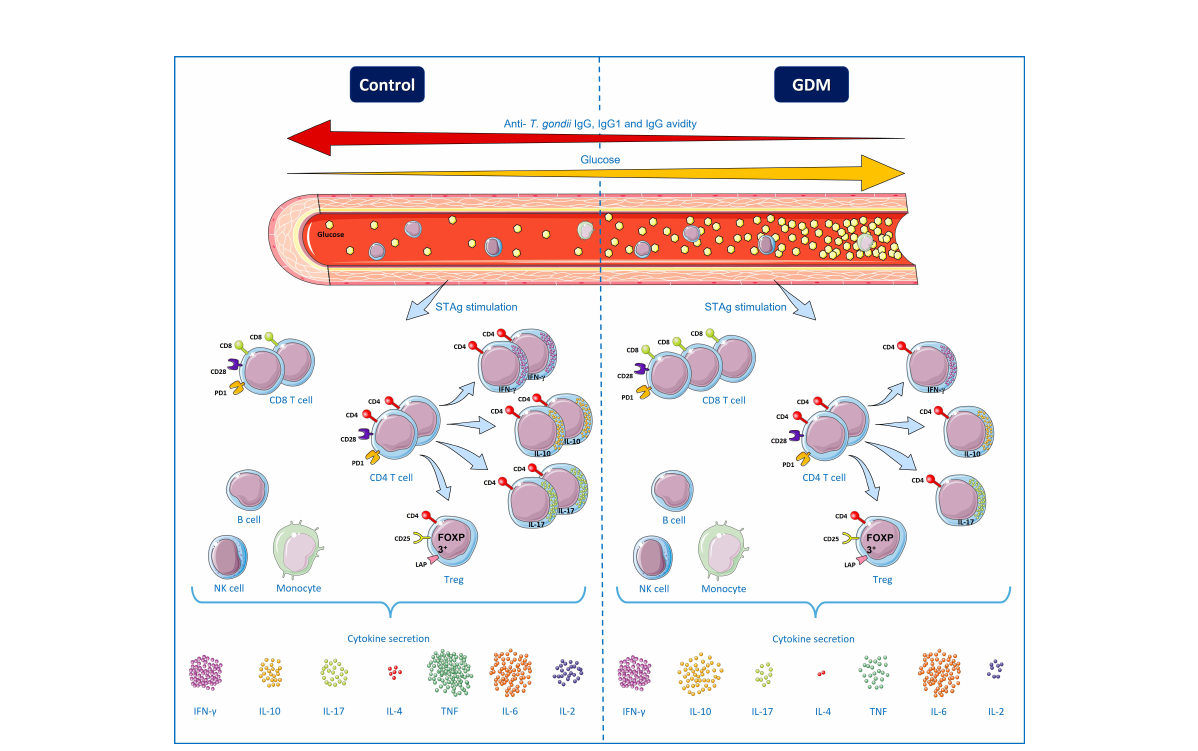
FIGURE 8 Speci fi c T. gondii immune responses from pregnant women chronically infected by the parasite, with and without gestational diabetes mellitus (GDM). High blood glucose levels characterize patients with GDM, while normoglycemic patients were identi fi ed as patients in the control group. There was a negative correlation between the blood glucose of PW and the levels of total IgG, IgG1 and IgG avidity, therefore, the higher the patient ’ s glycemia, the lower the level of anti- T. gondii antibodies. Under polyclonal stimuli (anti-CD3/anti-CD28), the GDM group patients had a higher number of T lymphocytes expressing the markers of cell activation and exhaustion (CD28 and PD-1), but in the presence of STAg, there was no difference. Under STAg stimuli, the number of CD8 + T cells was higher in the GDM group, while the number of CD4 + T cells was similar between the groups. However, the amount of CD4 + T lymphocytes producing IFN- g , IL-10 and IL-17 was signi fi cantly lower in the GDM group, while there was no difference between the groups in the amount of functional CD4 + CD25 High FOXP3 + LAP + Treg cells. IL-10 was secreted more by peripheral blood mononuclear cells (PBMC) of the GDM patients, there was no difference between the groups in the secretion of IFN- g and IL-6, while the secretion of cytokines IL-17, IL-4, TNF and IL -2 was lower in the GDM group. Therefore, compared to normoglycemic PW, PW who develop GDM have a decrease in the responses of the Th1, Th2 and Th17 pro fi le, as well as a decrease in IgG avidity and a correlation between the increase in blood glucose and the decrease in anti- T. gondii antibodies, suggesting an association between GDM and the negative modulation of cellular and humoral immune responses against T. gondii . B cells, NK cells and monocytes are separated by a box, to represent that they are also PBMCs, but they were not directly analyzed in this work. Terms of use: This fi gure is derived from images attributed